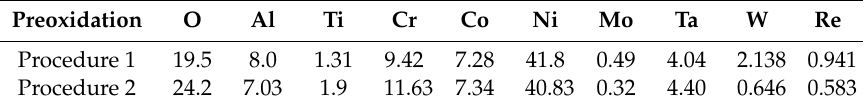
Table 5. EDS results of the sample surface after procedure 1 and procedure 2.